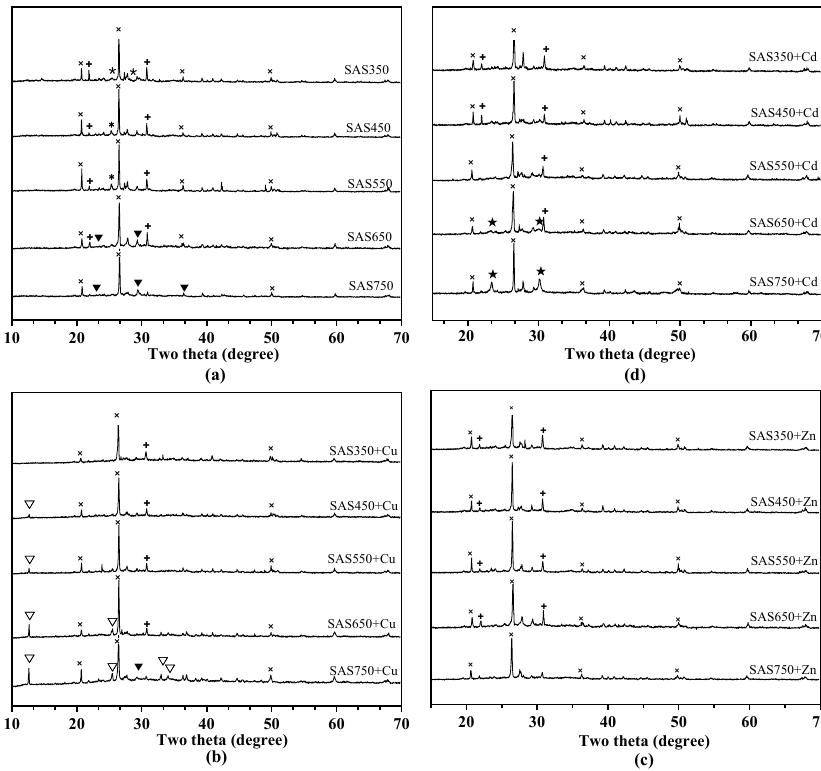
Figure 7. X-ray diffraction (XRD) patterns of biochars before ( a ) and after adsorbed with metal of Cu(II) ( b ), Zn(II) ( c ), or Cd(II) ( d ). Minerals with peaks labeled × , quartz (SiO 2 ); *, calcite (CaSO 4 ); ▼ , calcium carbonate (CaCO 3 ); ✚ , dolomite (CaMg(CO 3 ) 2 ); ▽ , posnjakite (Cu 4 SO 4 (OH) 6 H 2 O); ★ , Otavite (CdCO 3 ).